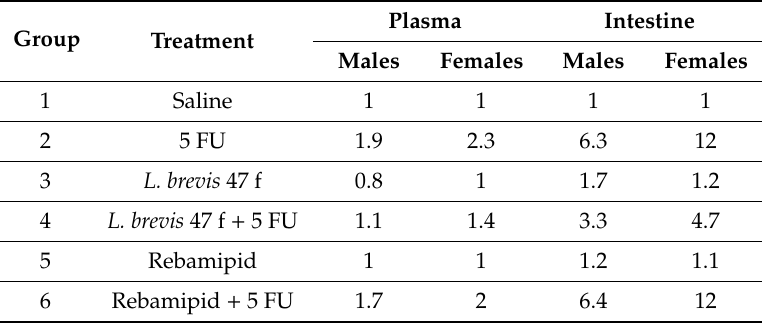
Table 7. Fold increase of MDA levels by day 10 after 5 FU